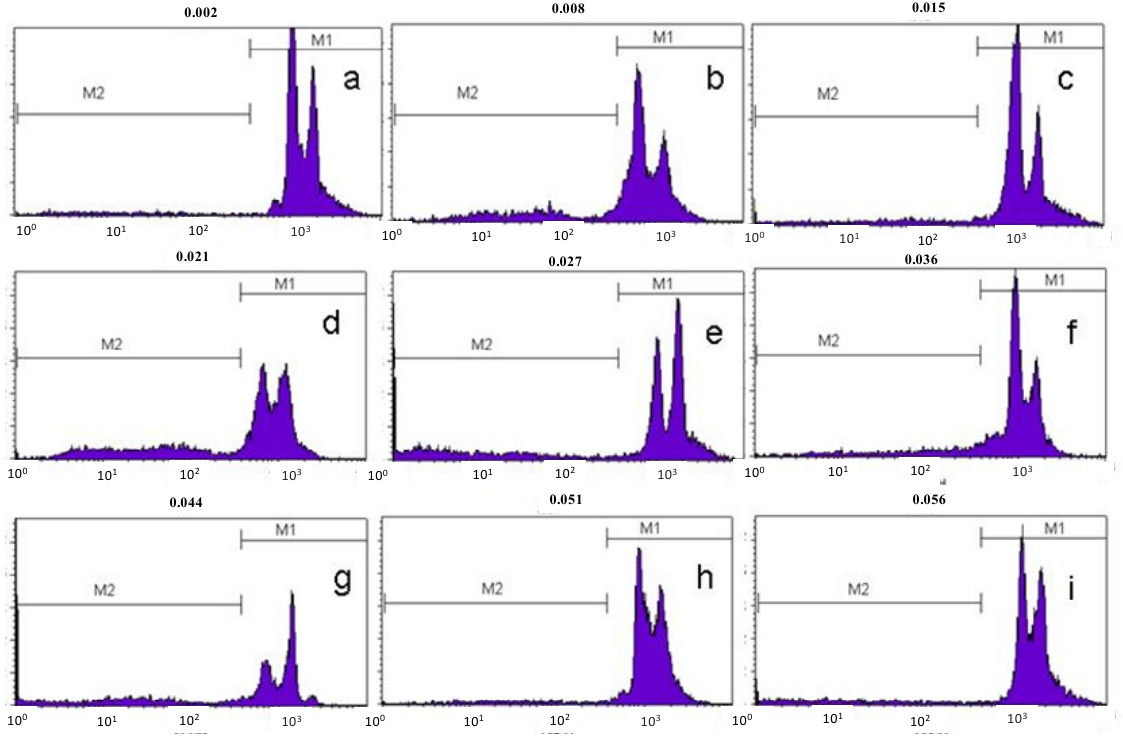
Figure 5. Histogram representation of DNA fragmentation in PC-3 cells in flow cytometry. M1 region corresponds to cells with intact DNA and M2 region corresponds to cells with fragmented DNA: ( a )—negative control, cells treated with diluent for 48 h; ( b )—cells treated with doxorubicin for 48 h; ( c )—cells treated with chalcone for 48 h; ( d )—cells treated with doxorubicin for 24 h; ( e )—cells treated with chalcone for 24 h; ( f )—cells treated with doxorubicin for 12 h; ( g )—cells treated with chalcone for 12 h; ( h )—cells treated with doxorubicin for 6 h; ( i )—cells treated with chalcone for 6 h. 0.002